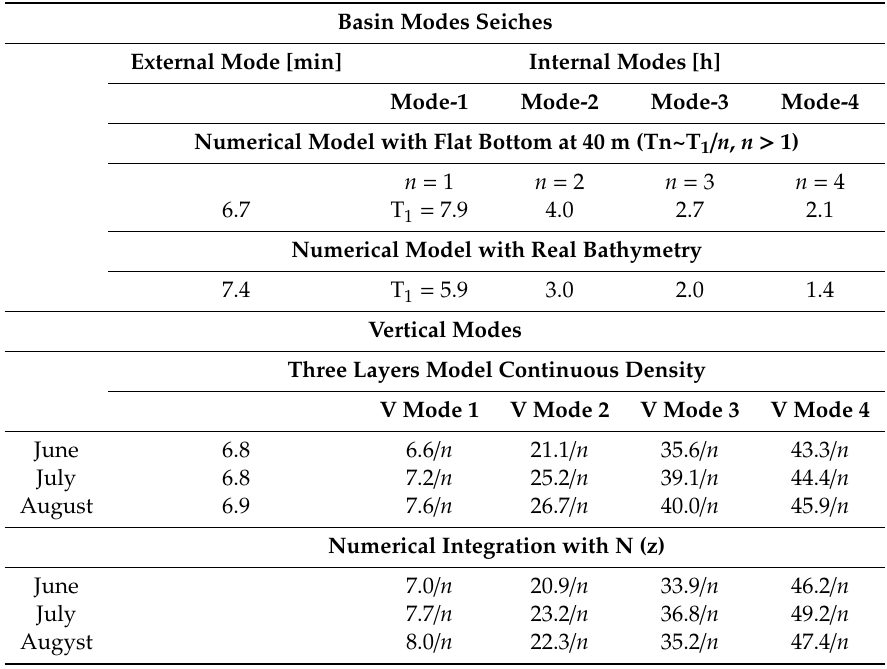
Table 3. Periods of normal basin and vertical modes of oscillation. With n the normal mode and T 1 the fundamental basin